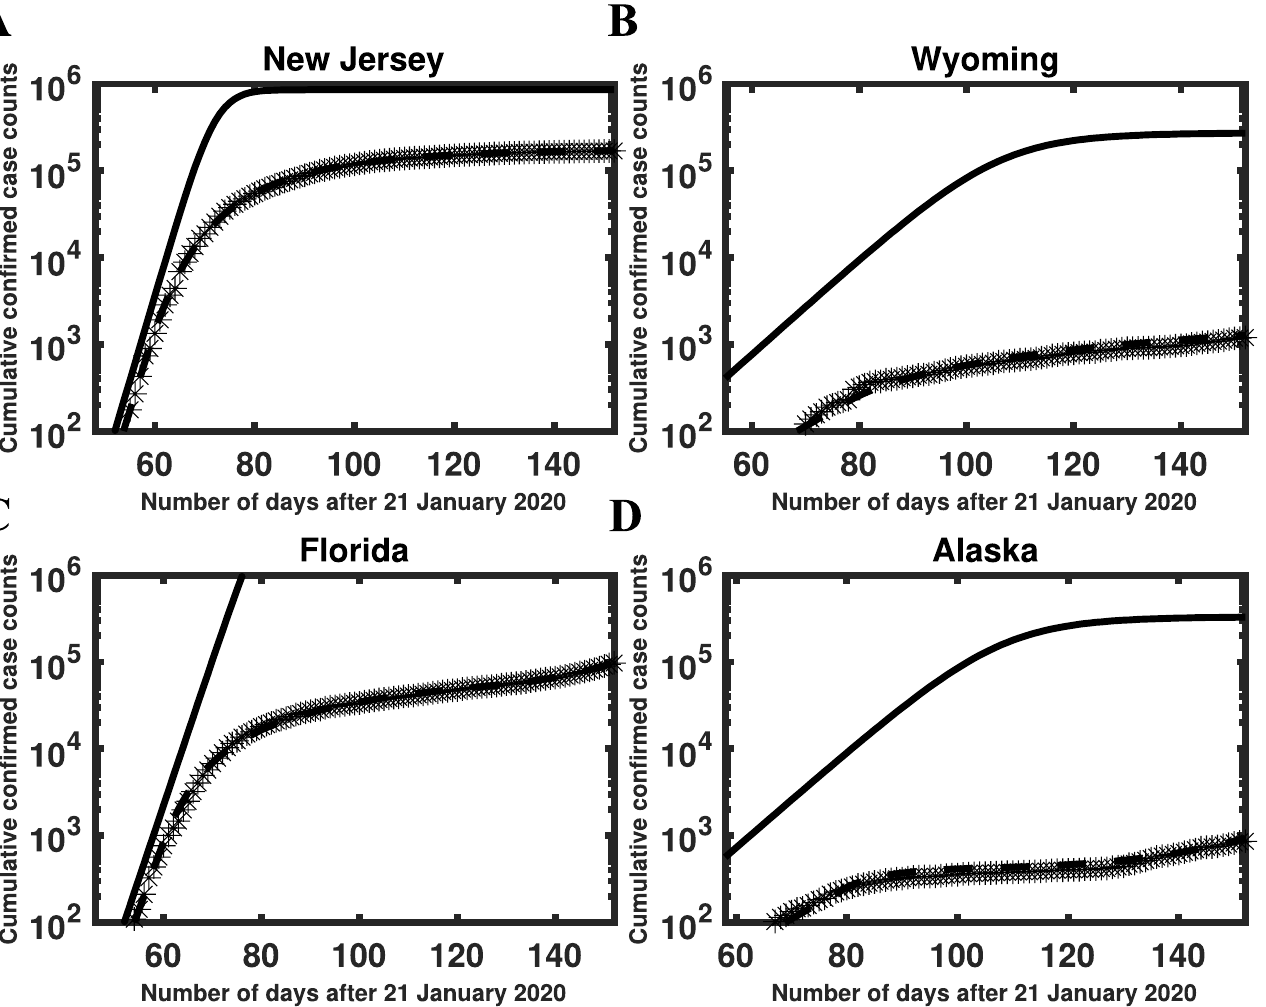
Figure 3. Consistency of model-derived λ estimates with empirical growth rates during initial exponential increase in disease incidence in ( A ) New Jersey, ( B ) Wyoming, ( C ) Florida, and ( D ) Alaska. In each panel, the initial slope of the solid curve corresponds to λ (calculated as described in Materials and Methods), the crosses indicate empirical cumulative case counts, and the broken line is the model prediction based on MAP estimates for adjustable parameters. The solid curve is derived from the reduced model (Equations (1)–(8) in the Supplementary Materials Text S1). This curve shows cumulative case counts had there not been any interventions to limit disease transmission. As can be seen, the initial slopes of the solid and broken curves are comparable. We selected 𝑛 = 0 for New Jersey and Wyoming and 𝑛 = 1 for Florida and Alaska. Among 35 states with 𝑛 = 0 , New Jersey had the largest inferred λ value (0.45) and Wyoming had the smallest inferred 𝜆 value (0.13). Among 15 states with 𝑛 = 1 , Florida had the largest inferred value of 𝜆 (0.39) and Alaska had the smallest inferred value of 𝜆 (0.13). It should be noted that, in contrast with Figure 1, the y-axis here indicates cumulative (vs. daily) number of cases on a logarithmic (vs. linear) scale. Table 1. Maximum a posteriori (MAP) estimates and 95% credible intervals for epidemic parameters ( β , λ , ℛ 0 , HIT, and Delta-adjusted HIT) for the states of New Jersey, Wyoming, Florida, and Alaska.